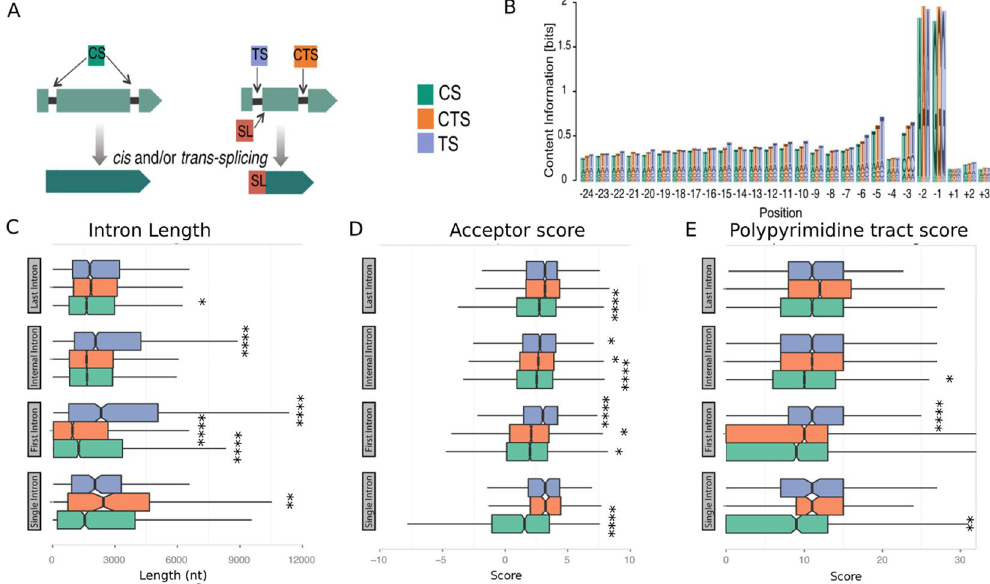
Figure 8. Cis and trans-splicing features based on the intron positions. ( A ) Introns were subdivided in three distinct groups for the following analysis: CS - cis-spliced introns (green boxes), CTS - cis-spliced introns in trans-spliced transcripts where the intron is not the primary SLTS target (orange boxes), and TS trans-spliced introns (purple boxes). ( B ) Intron/exons boundaries represented by the region from − 24 to + 3 nucleotides. Acceptor splice sites in SL-containing genes were analysed based on their sequence composition. ( C ) Intron lengths are plotted based on their position in genes (single, first, internal, and last introns). ( D ) The strengths of acceptor splice sites (log-odds scores) are plotted according to the intron position in genes of the same three distinct groups. ( E ) Length of the polypyrimidine tract in nt relative to the acceptor sites are plotted according to intron position in genes of the same three distinct groups. Significantly differences are pointed (Kolmogorov- Smirnov test, * p < = 0.05, ** p < = 0.01, *** p < = 0.001, **** p < =